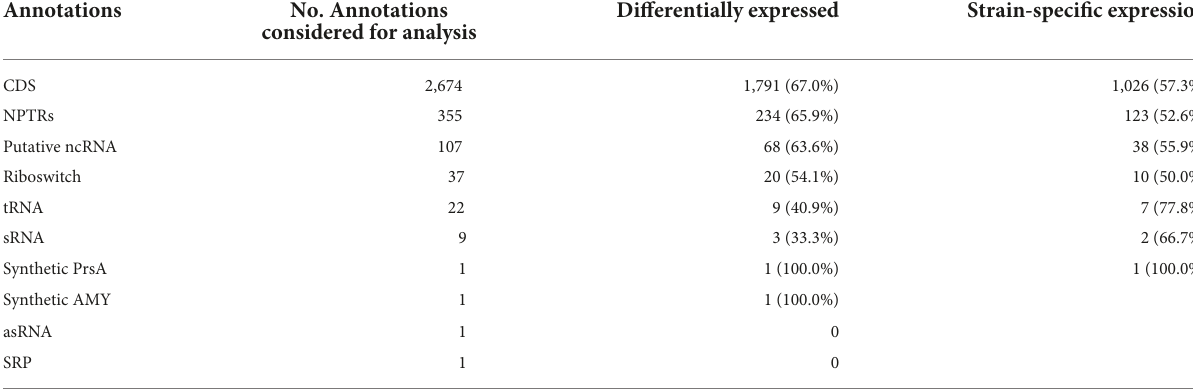
TABLE 1 Differentially expressed annotations.